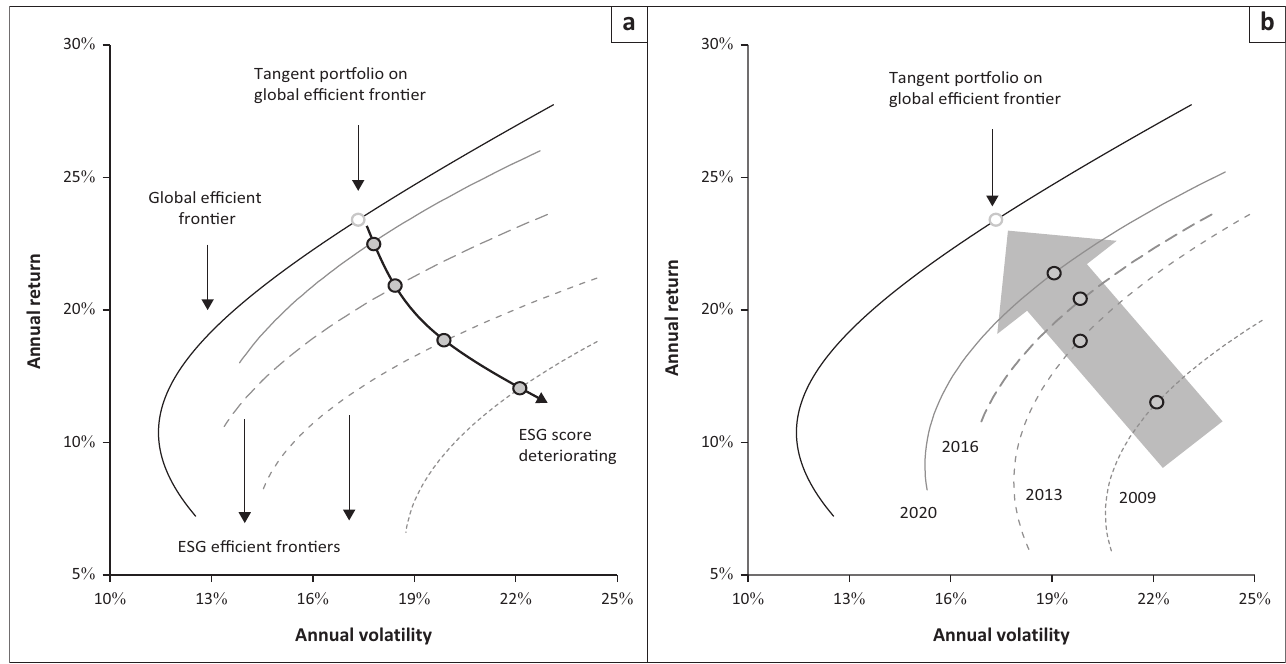
ESG, environmental, social and governance. FIGURE 7: Return-risk loci for the global efficient frontier score and environmental, social and governance (ESG)-constrained frontiers as a function of ESG scores: (a) as the ESG score deteriorates, the maximal tangent portfolio moves down and right (southeast), that is, lower returns and higher risk and (b) time evolution of ESG- constrained efficient frontiers for South African portfolios. ESG monotonically increases over the period from 50 to 60. Grey arrow indicates the direction of improving ESG scores and their effect on the ESG efficient frontier’s tangent